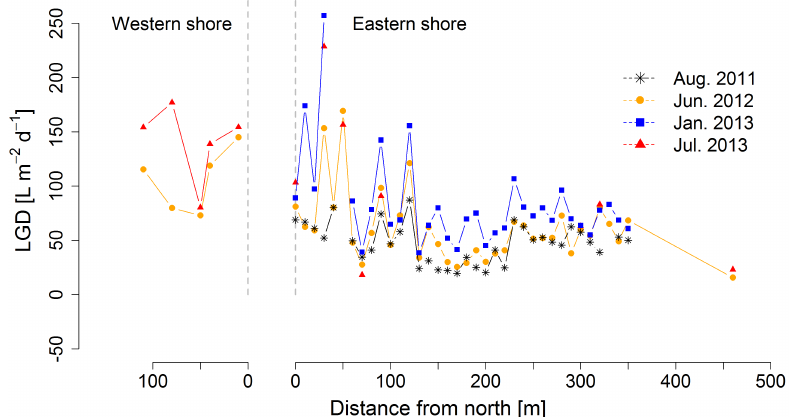
Figure 4. Calculated LGD rates from repetitions of VTP measurements in August 2011, June 2012 and January and July 2013 at the western and eastern shores in the northern part.